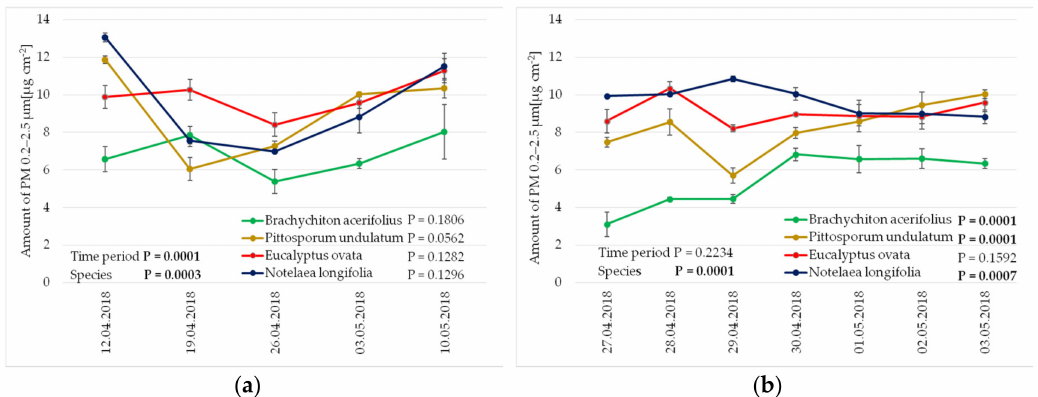
Figure 5. Amount of fine PM fraction (0.2–2.5 µ m) PM deposited on leaves of B. acerifolius, P. undulatum , E. ovata and N. longifolia during ( a ) five weeks and ( b ) seven days of measurements. Data are means ± SE, n = 3. P values in bold indicate statistical